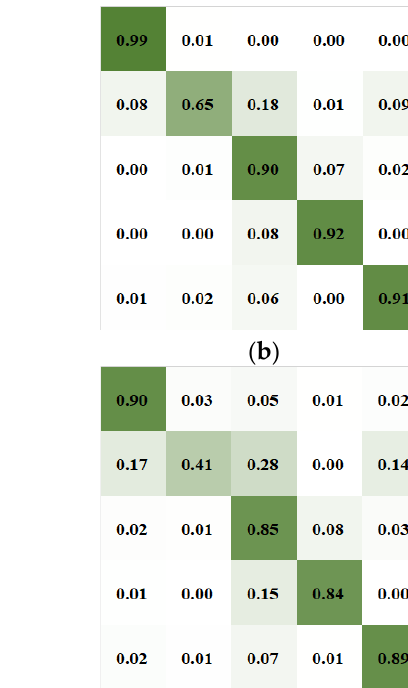
Table 3. Confusion matrix of Sleep-EDFX-8 dataset.